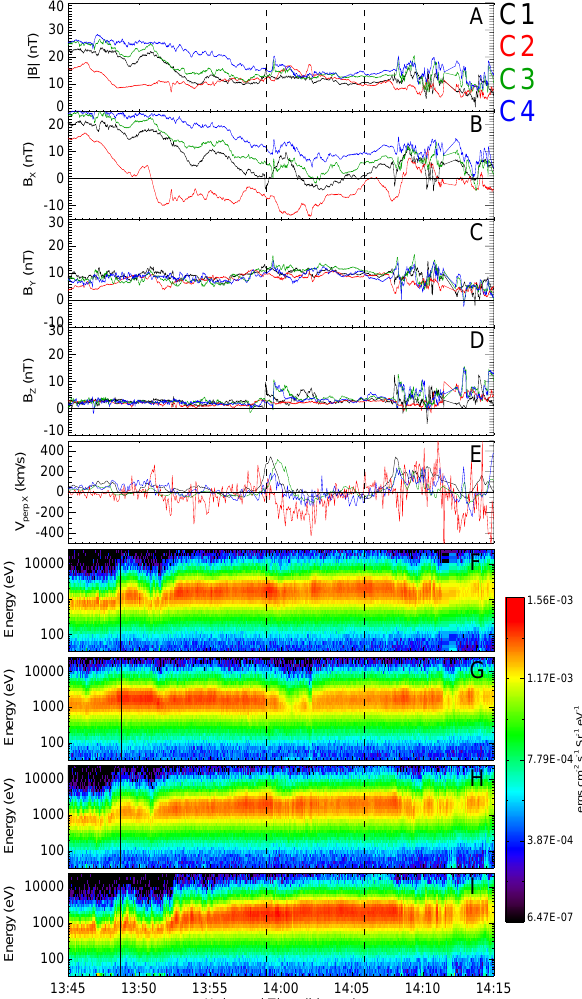
Fig. 4. An overview of the interval of interest. Panel (A) shows the magnitude of the magnetic field as measured by FGM for C1, C2, C3 and C4 (black, red, green and blue traces, respectively); pan- els (B–D) show the three vector components of magnetic field in the GSM coordinate system; panel (E) shows the X component of the field-perpendicular velocity projected onto GSM axes for ions, as measured by CIS-HIA (C1 and C3); protons as measured by CIS- CODIF (C4) and electrons as measured by PEACE (C2). Panels (F– I) show energy-time spectrograms of omnidirectional differential energy flux for electrons from PEACE for C1, C2, C3 and C4 re- spectively. The dashed black line labelled 1 marks the feature of interest, shown in more detail in Figs. 5, 6, 7 and 8. The dashed black line marked 2 shows the time of substorm onset in the image FUV